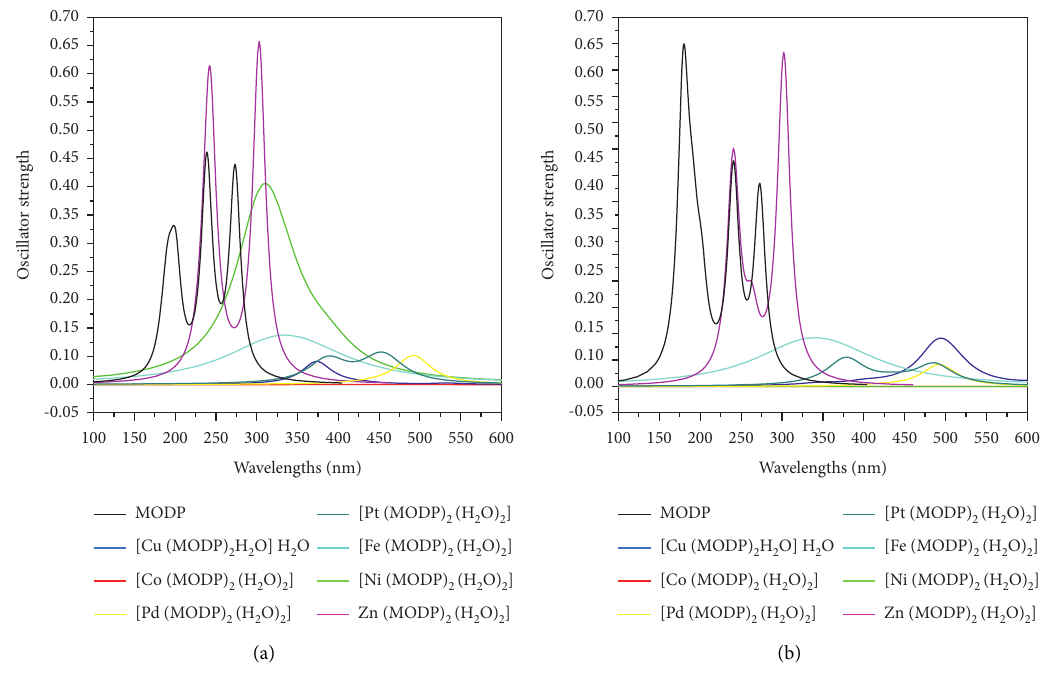
Figure 5: Absorption spectra of MODP and its complexes at the CAMB3LYP/def2-TZVP theory level in (a) gas phase and (b) DMSO